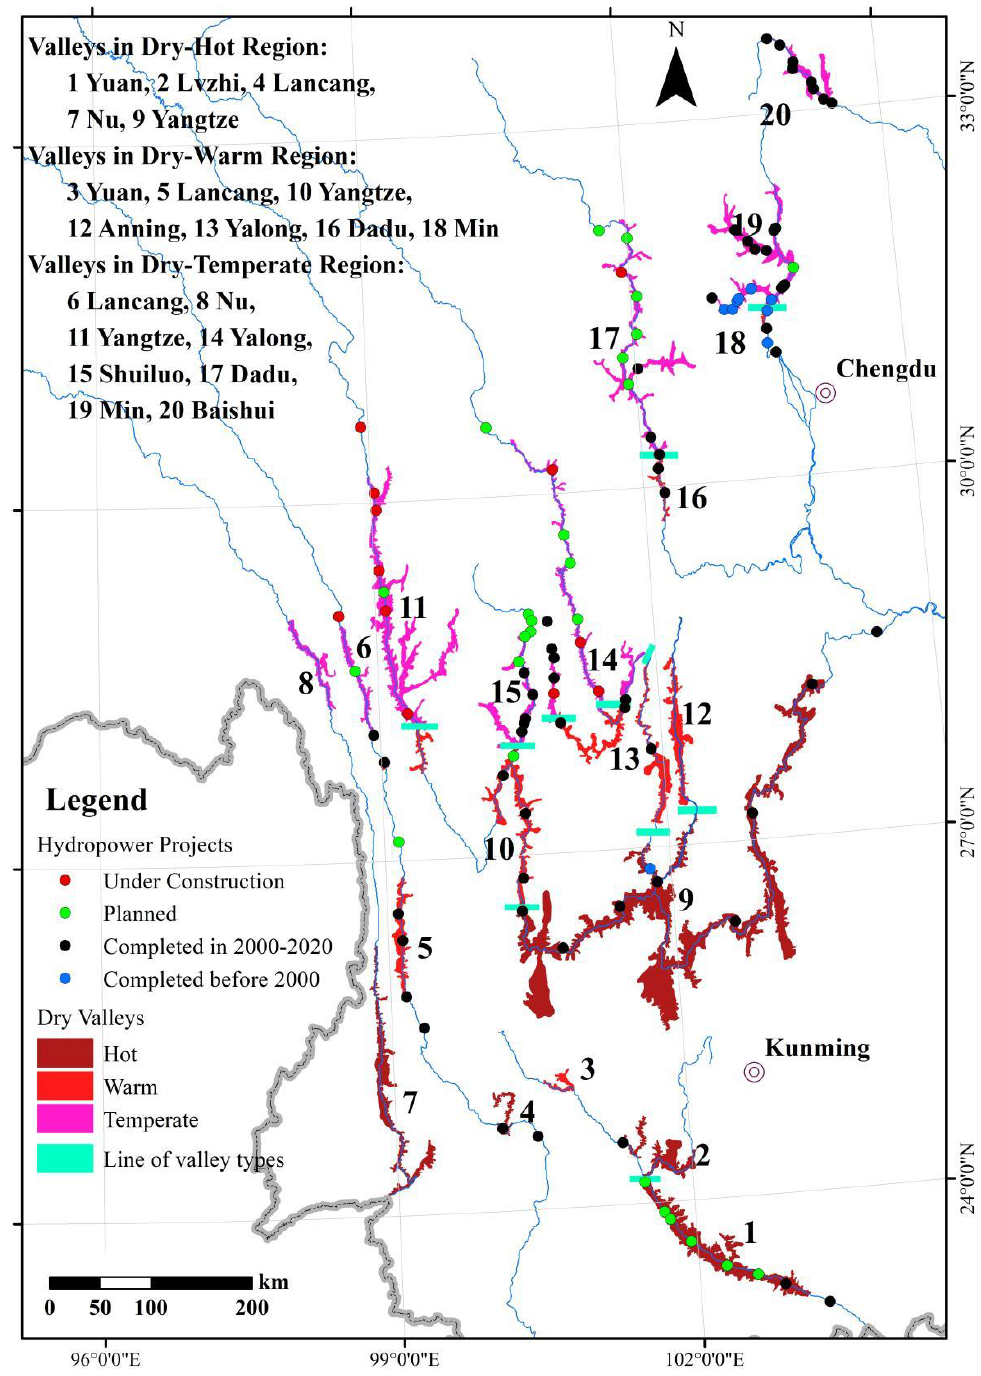
Figure 5. Geographical distribution of hydro-power projects in dry valleys of Southwest China.